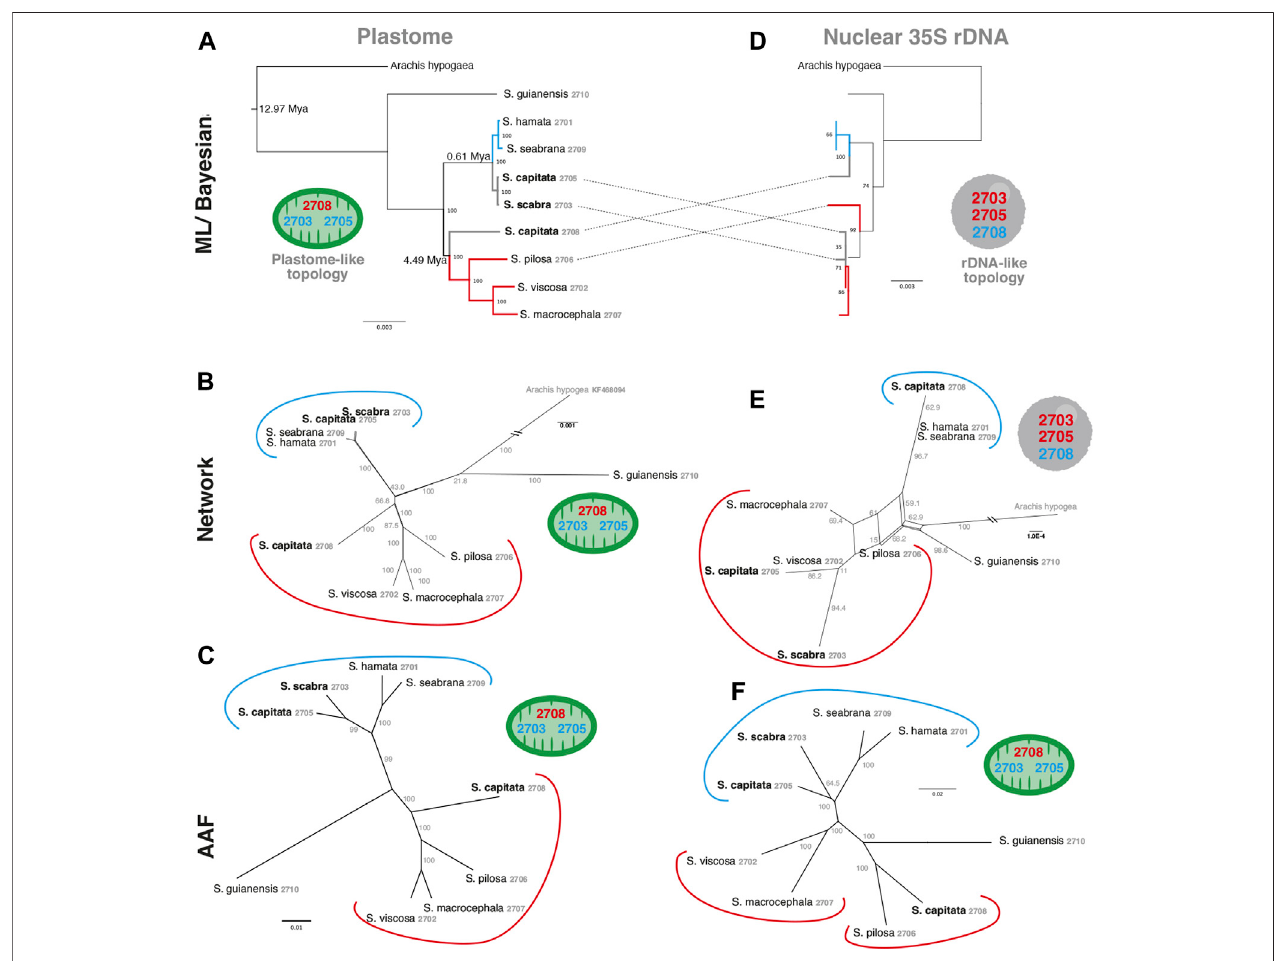
FIGURE 5 | A comparison of alignment-based (A , D) , network analysis (B , E) and AAF (C , F) phylogenies of plastome (left) and rDNA (right) sequences including Stylosanthes allopolyploids. Ages of allopolyploid origins are indicated on Figure 5A . Blue branchesindicate A genome-speci fi c and red branches group other genome types. Numbers indicate speci fi c codes for each sample (see Table 1 ). Green and gray circles indicate chloroplast-like or nuclear-like topologies, respectively.